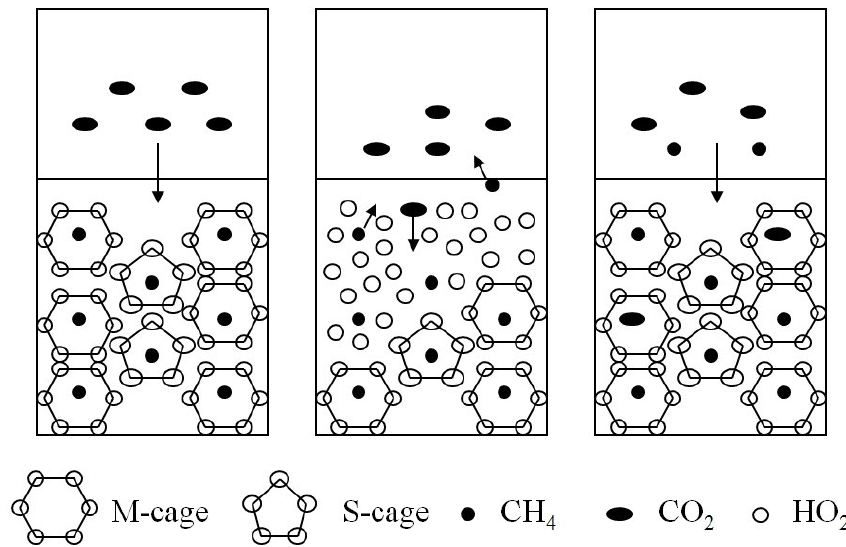
Figure 2. Schematic diagram of the guest molecule replacement in the M-cage and the CH re-occupation in the 4